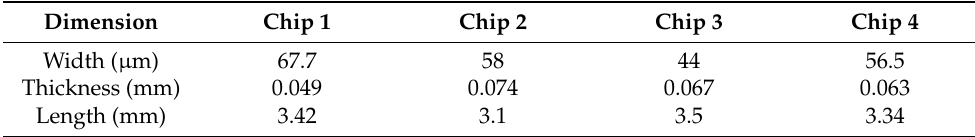
Table 1. Aluminium AA7075 chips’